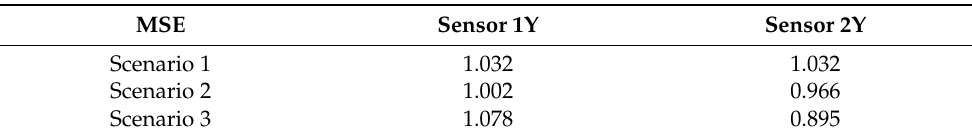
Table 5. The MSE values, based on the scenario and sensor location, for the reference transient simulation on the test rig.